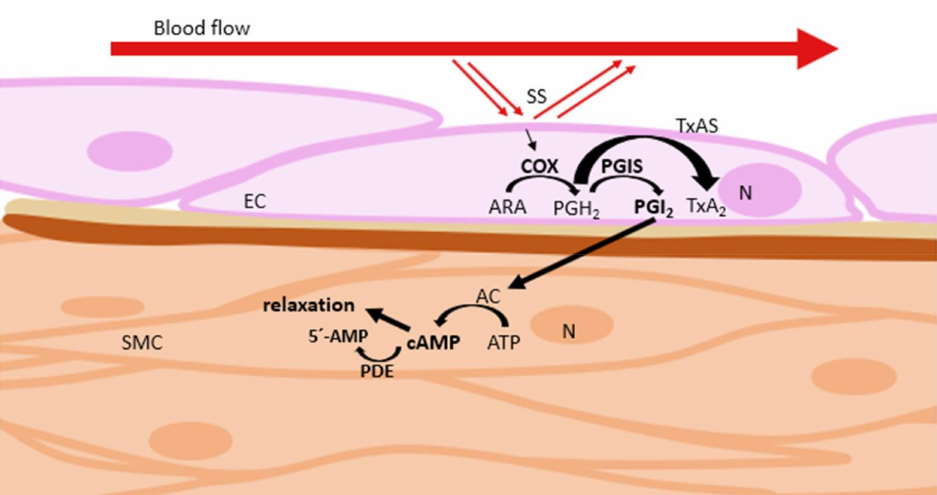
Figure 7. Regulation of vascular tone via inhibition of phosphodiesterase. AC: adenylyl cyclase; ARA: arachidonic acid; ATP: adenosine triphosphate; cAMP: cyclic adenosine monophosphate; COX: cyclooxygenase; EC: endothelial cell; N: nucleus; PDE: phosphodiesterase; PGH 2 : prostaglandin H 2 ; PGI 2 : prostacyclin; PGIS: prostacyclin synthase; SMC: smooth muscle cell; SS: shear